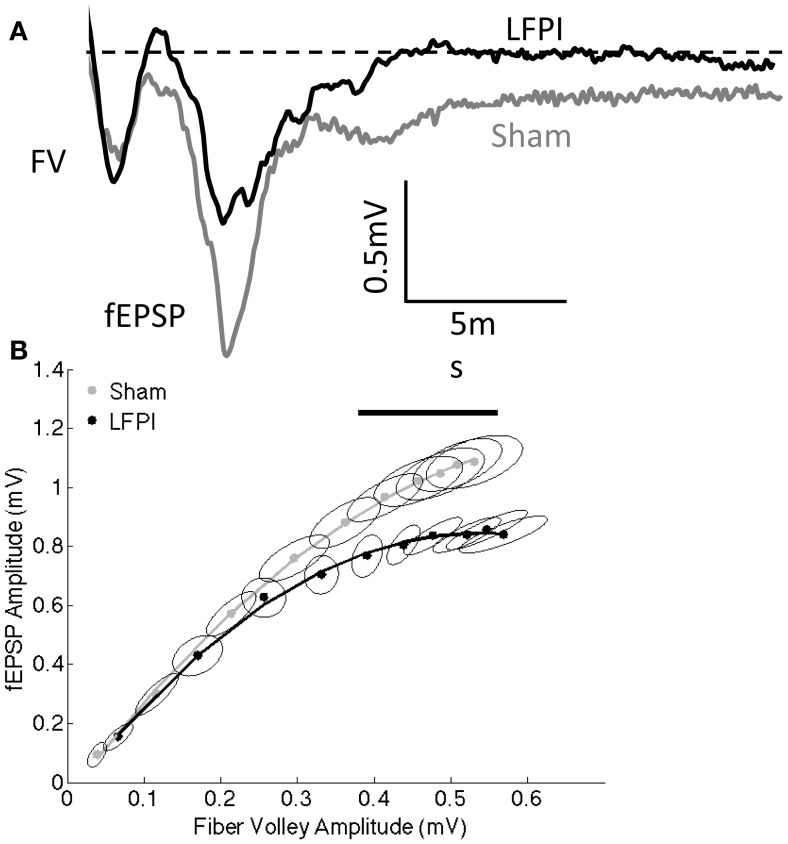
Decreased field excitatory postsynaptic potentials following LFPI. (A) Representative extracellular recordings at the highest stimulation intensity used (300 μA). Fiber volley amplitude is unchanged; however, fEPSP amplitude is reduced in response to LFPI. Dashed line indicates baseline voltage, aligned for both traces. FV denotes fiber volley, fEPSP denotes the field excitatory postsynaptic potential. (B) Fiber volley amplitude and fEPSP amplitude at stimulation intensities ranging from 30–300 μA. Error ellipses indicate the 95% confidence area for each measure. The horizontal line above the data indicates the fiber volley amplitudes for which the groups differ in fEPSP amplitude as assessed by a permutation-based bootstrapping method at the α = 0.05 level.